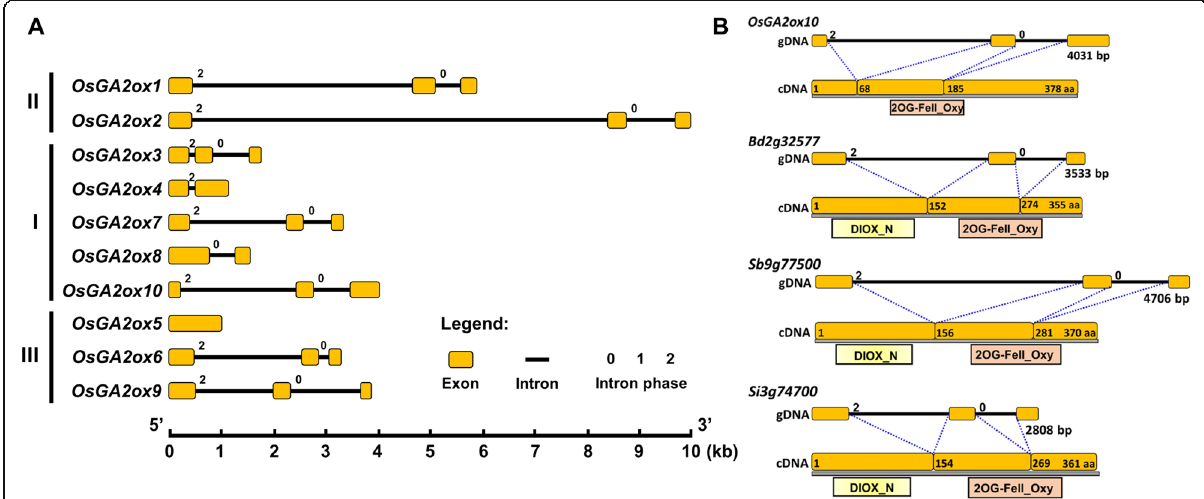
Fig. 9 Gene structure of the rice GA2ox family members and comparison of the functional domains in OsGA2ox10 and its orthologous genes. a Gene structures of all 10 rice GA2ox genes. The sizes of exons (box) and introns (line) are shown on the same scale. The numbers on top of each exon/intron junction indicate their intron phases. b Schematic diagram showing the exon-intron gene structure and amino acids encoded by the